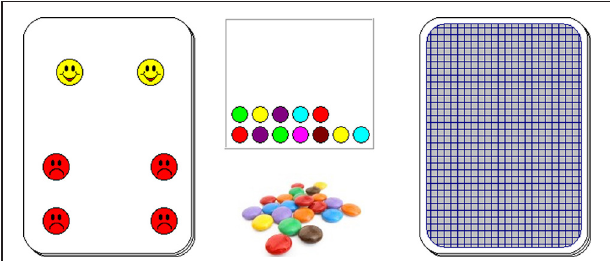
FIGURE 1 | Sample card from the disadvantageous deck of the Children Gambling Task-Br.